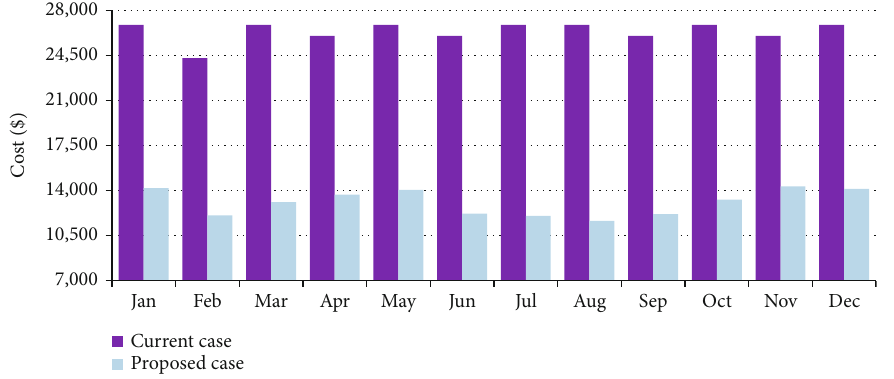
Figure 35: Monthly utility bills for the current and proposed systems for Burundi. Table 14: Annual utility bills and savings by category (Burundi). Table 17 indicates the monthly utility summary for the Consumption charge Total Base